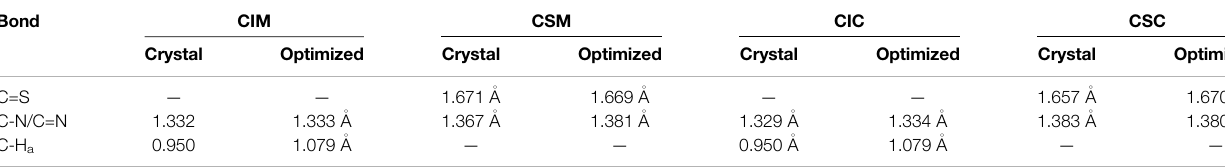
TABLE 1 | Bond lengths between the crystal and optimized structures of CIM , CSM , CIC , and CSC . Bond CIM